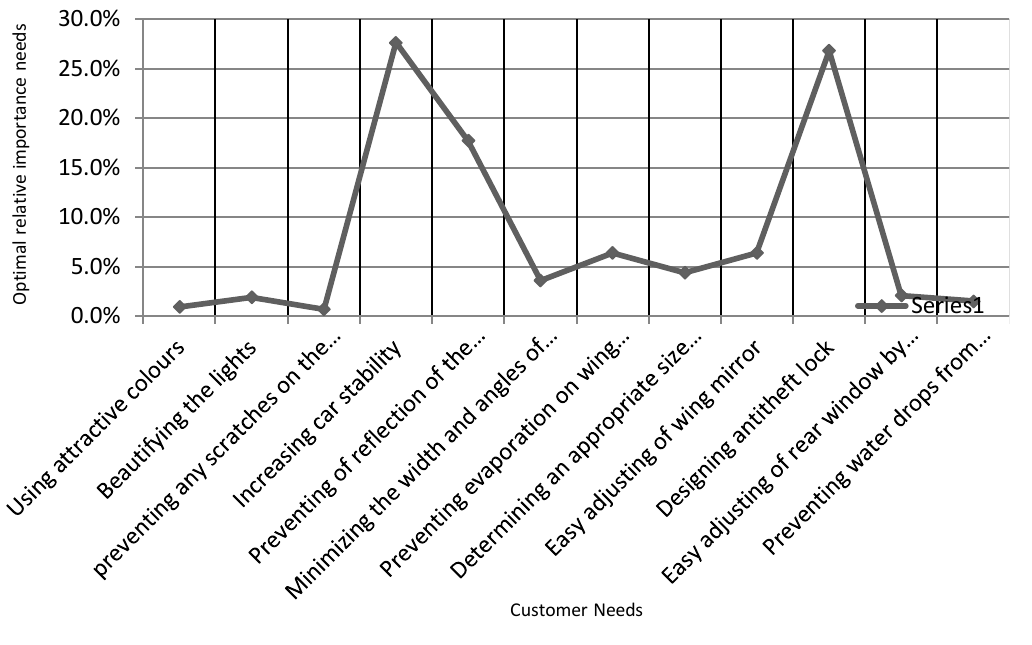
Figure 8. The relative optimal value of customer needs